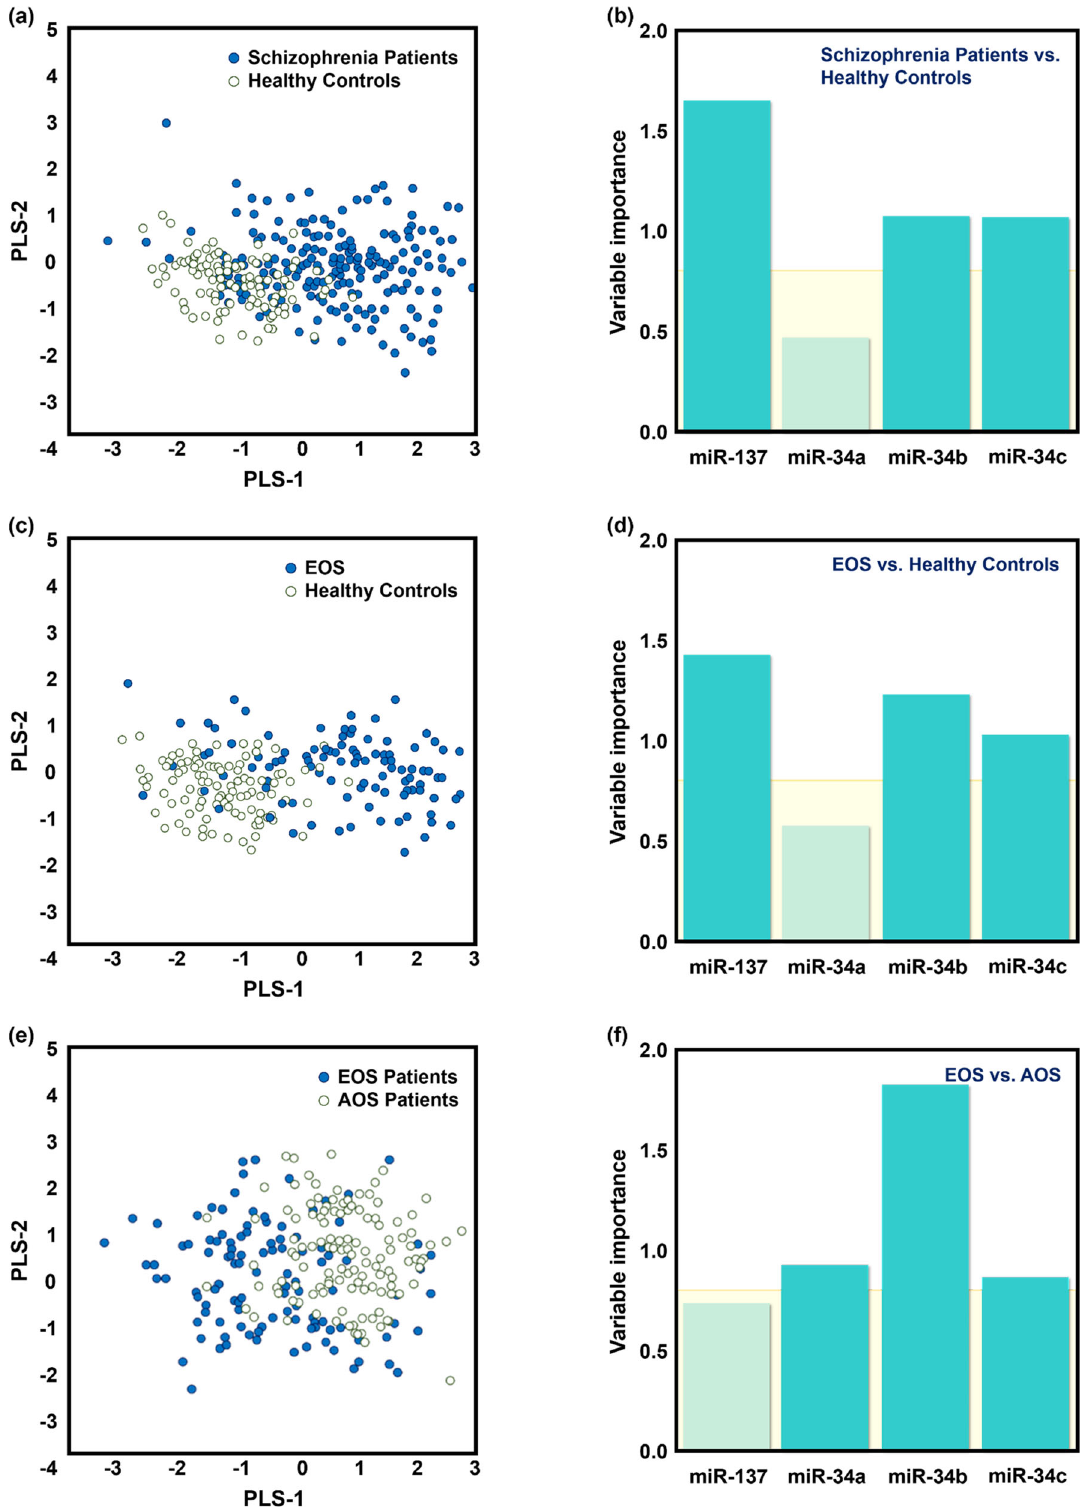
Fig. 2 Partial least-squares discriminant analysis (PLS-DA) and variable importance in the projection (VIP) of the selected miRNAs in the study groups. Score plots derived from the PLS-DA for a the level of miR-137 expression between patients with schizophrenia and healthy controls, b the level of miR-137 expression between EOS and healthy controls, and c the level of miR-34b expression EOS and AOS patients. VIP data for the d patients with schizophrenia versus healthy controls, e EOS patients versus healthy controls, and f EOS patients versus AOS patients. AOS adult-onset schizophrenia, EOS early-onset